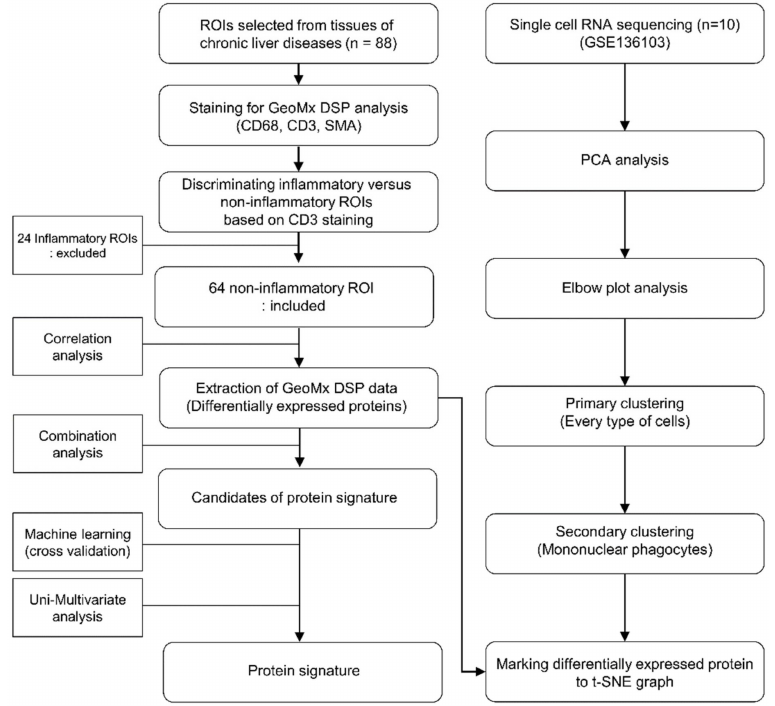
Figure 1. Flow chart of the DSP analysis and the single cell-DSP